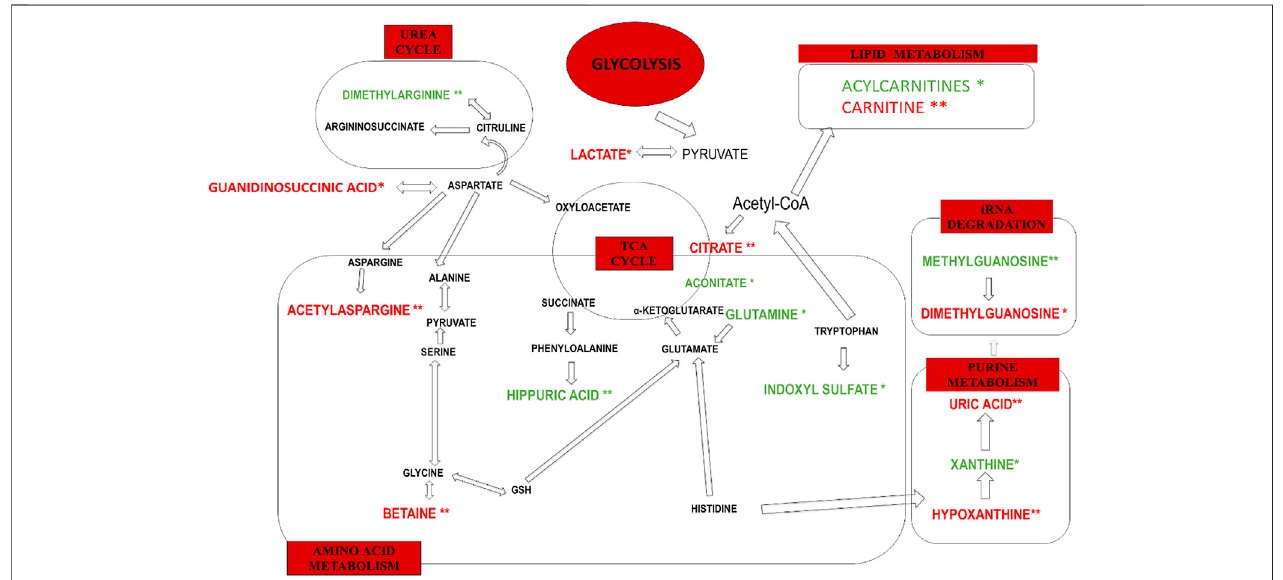
FIGURE4| Themainbiochemicalpathwaysalteredonlyinrenaldysplasia(*)andrenaldysplasiaaccompaniedbydecreasedeGFR(**).Decreasedlevelsofurinary metabolites are marked in green. Increased urinary metabolite levels are marked in red.